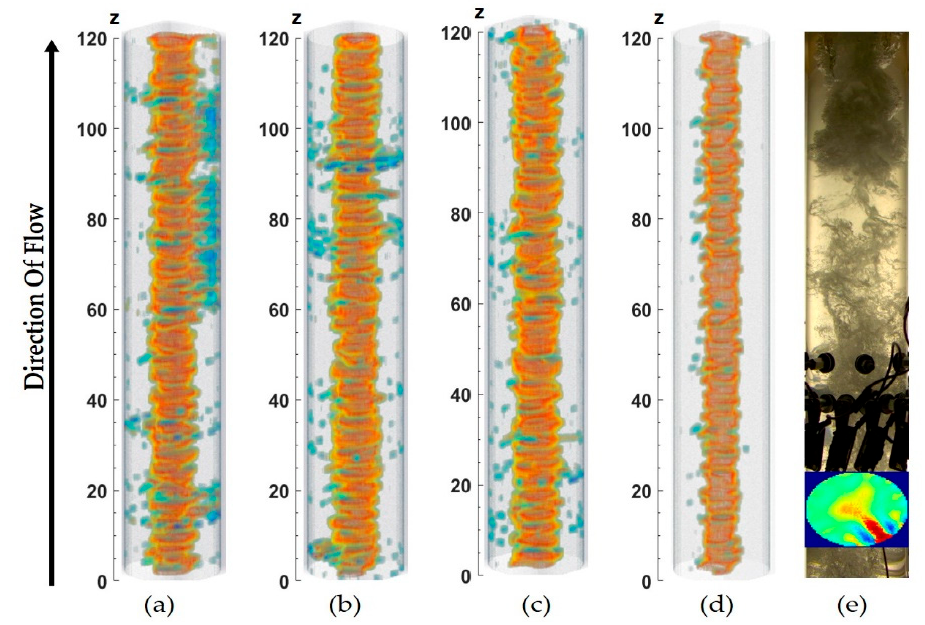
Figure 20. 2.5D images for: ( a ) Experimental point 3 ( b ) Experimental point 4 ( c ) Experimental point 5 ( d ) Experimental point 6. ( e ) Manually calibrated ERT and camera image showing the failure of ERT due to gas core breakage.